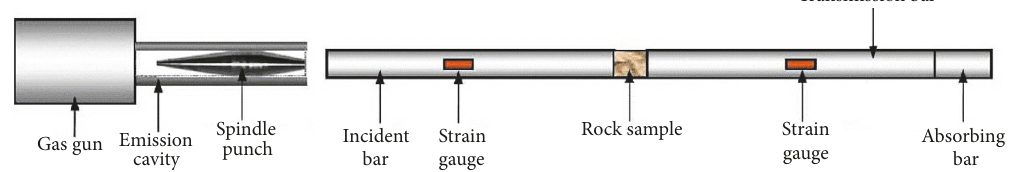
Figure 2: Typical SHPB testing